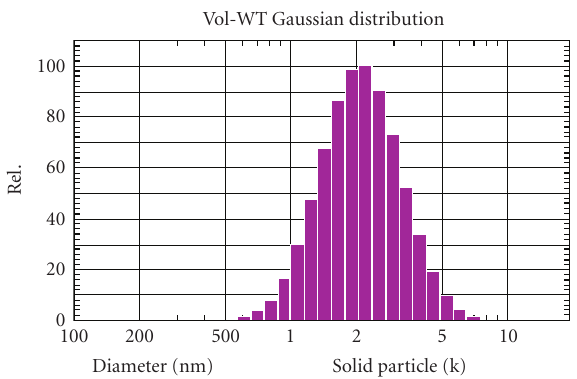
Figure 12: Size distribution probability of typical “ultrafine” white carbon